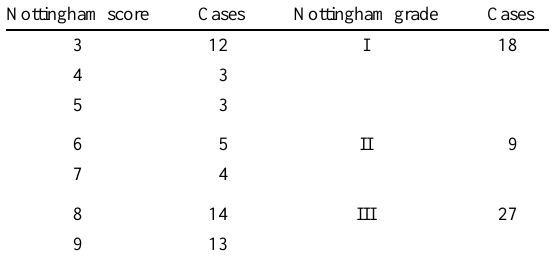
Breakdown of the number of cases in each category of the Notting- ham scoring system. Scores from 3–5 are Nottingham grade I, 6–7 are grade II, and 8–9 are grade